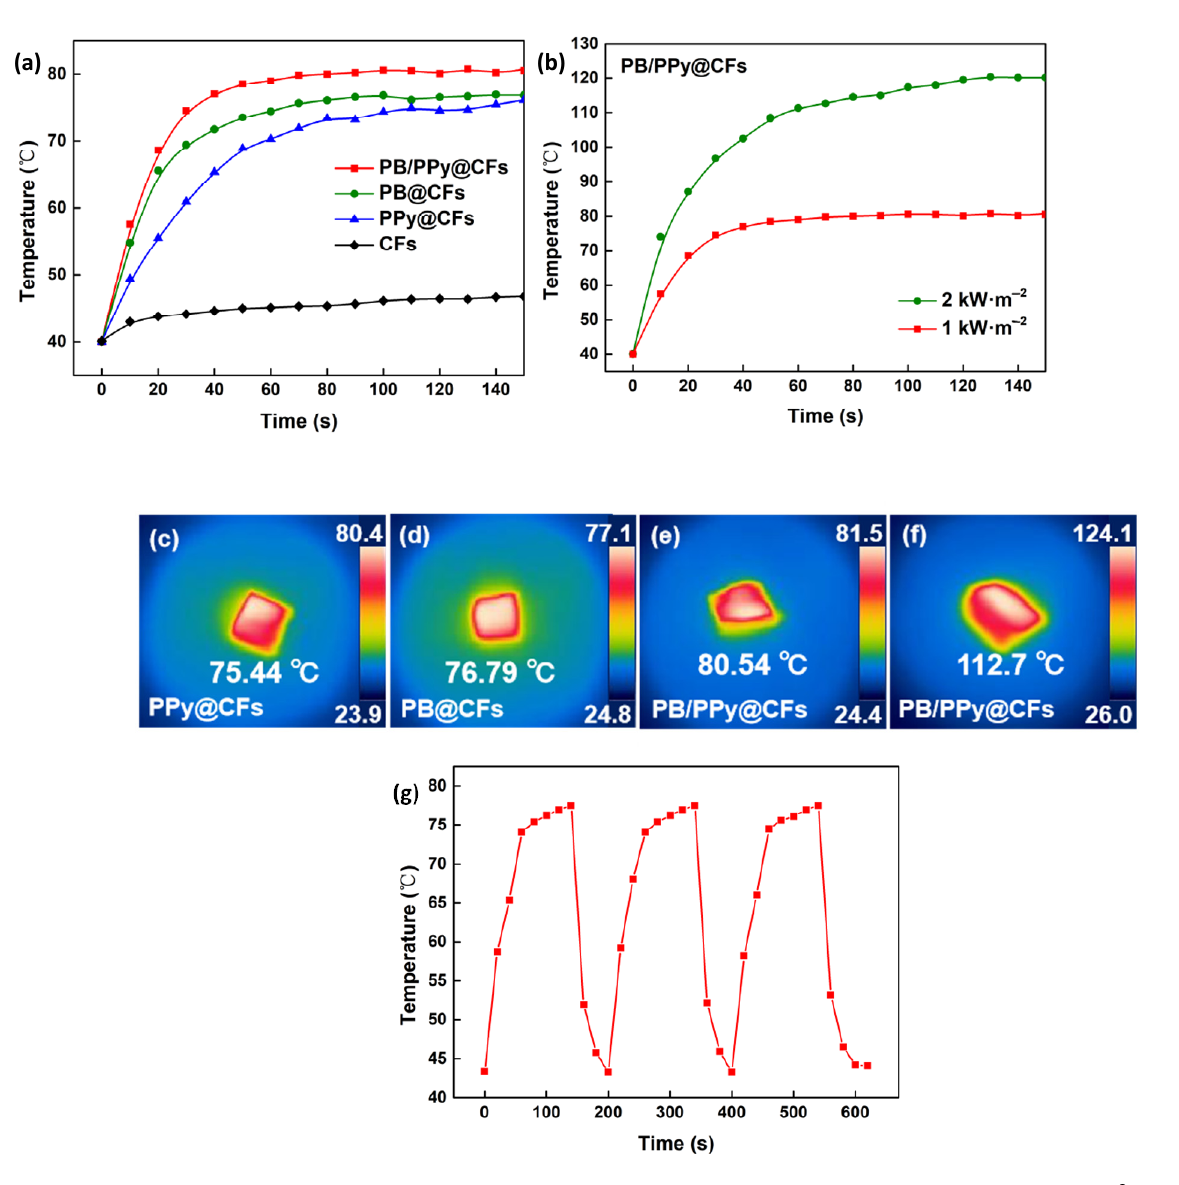
Figure 10. ( a ) Variation of surface temperature of different samples with time at 1 kW · m − 2 ; ( b ) Variation of surface temperature of PB/Ppy@CFs with time at 1 kW · m − 2 and 2 kW · m − 2 ; ( c – e ) Infrared imaging photos of Ppy@CFs, PB@CFs, and PB/PPy@CFs at 1 kW · m − 2 ; ( f ) Infrared imaging photo of PB/PPy@CFs at 2 kW · m − 2 ; ( g ) Heating/cooling cycle of PB/PPy@CFs at 1 kW · m − 2